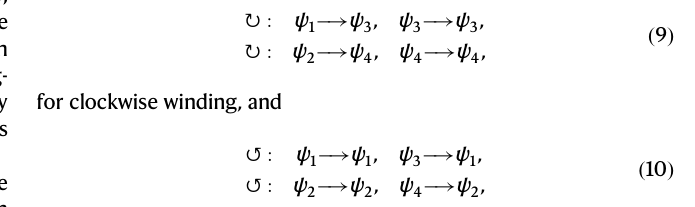
broken PT-phase at the half period, a diabolically degenerate exceptional point (DDEP) is formed that connects various energy Riemann sheets. The presence of a DCisindicatedbytheintersectionoftwopairsofplanes(theredandyellowsheets, andthegreenandbluesheets).Theencirclingtrajectories(blacksolidcurves)cross the DC at some point, i.e., a DP. Trajectories of all eigenmodes coincide when crossing a DC and are represented by the grey ball. c , f Final state at t = T , with the same system parameters as for the initial state: the eigenmodes are permuted compared to the initial modes, and that shuf fl ing depends on the direction of the encircling and whetherthe encircling trajectorypasses throughthe DCor not.The DC crossing is induced by the appropriate time modulation of the coupling g (see the main text for more